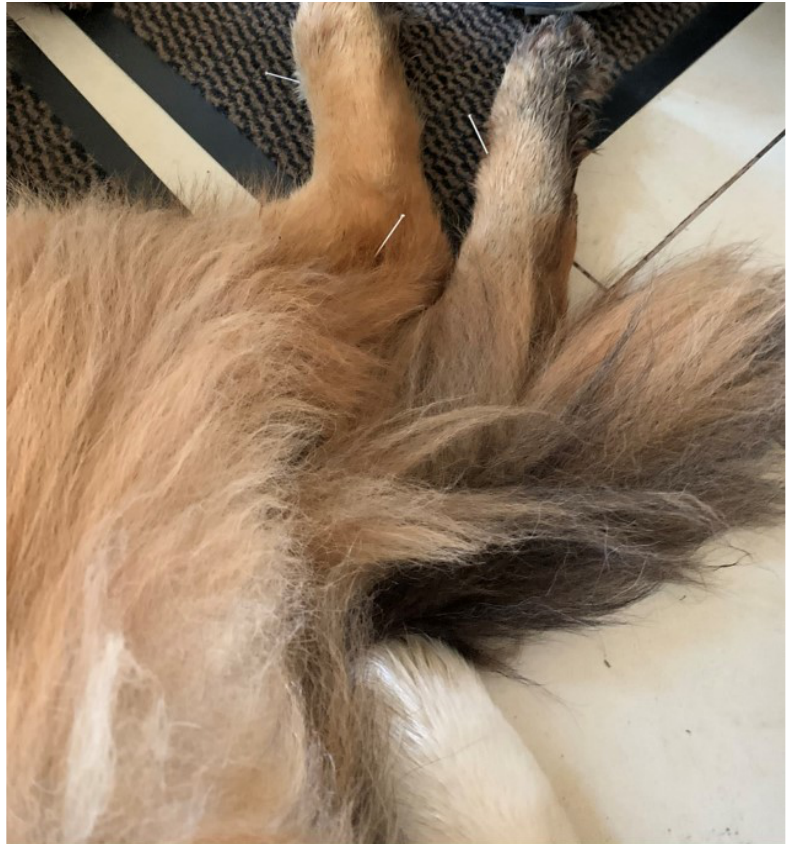
Figure 2. Rufus during the treatment: LIV3 (bilaterally),